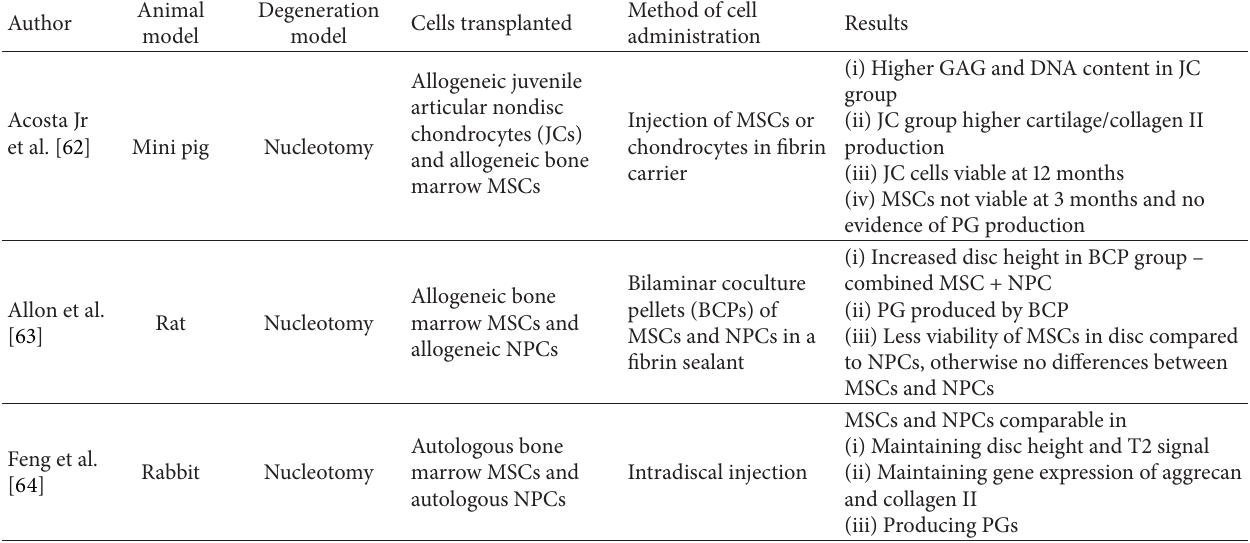
Table 3: Studies comparing the efficacy of MSCs and chondrocytes to regenerate lumbar intervertebral discs.